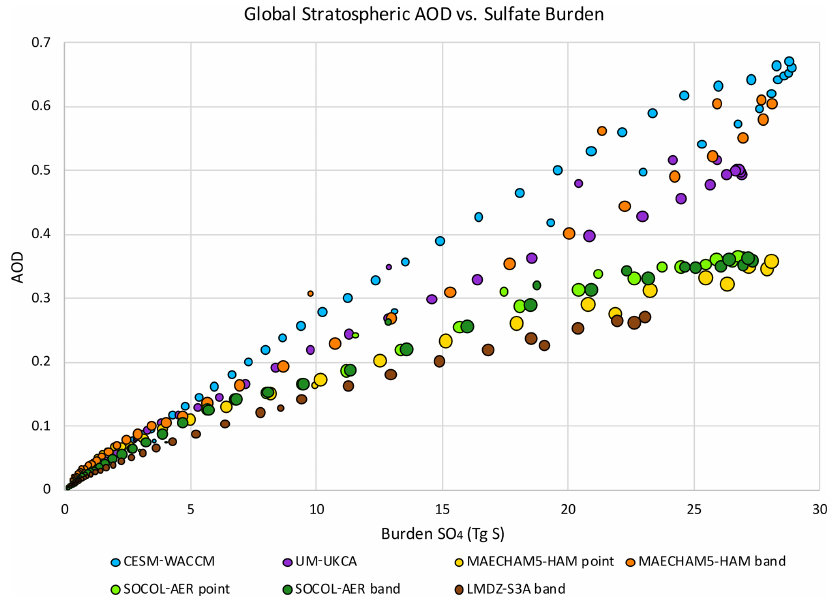
Figure 5. Global stratospheric AOD in the visible vs. sulfate burden from VolMIP-Tambora ISA ensemble means. Circle size is scaled by π(R eff ) 2 .